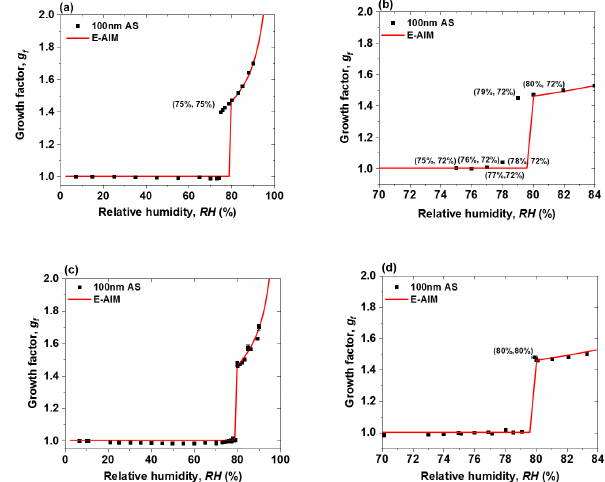
Figure 3. Sizing accuracy and sizing offset of nano-DMAs after calibration. (a) Normalized number size distribution scanned by the nano-DMA2 for 100nm PSL nanoparticles (black solid square). Normalized number size distributions scanned by the nano-DMA2 for 100nm PSL nanoparticles (b) and 60nm (c) and 10nm (d) am- monium sulfate (AS) selected by the nano-DMA1 at RH below 5% at 298K (black solid square). The dotted lines mark the diameters of the monodispersed nanoparticles selected by the nano-DMA1, i.e., 100nm in (b) , 60nm in (c) , and 10nm in (d) . The black solid lines mark the peak diameters from the Gaussian fits (red curve).